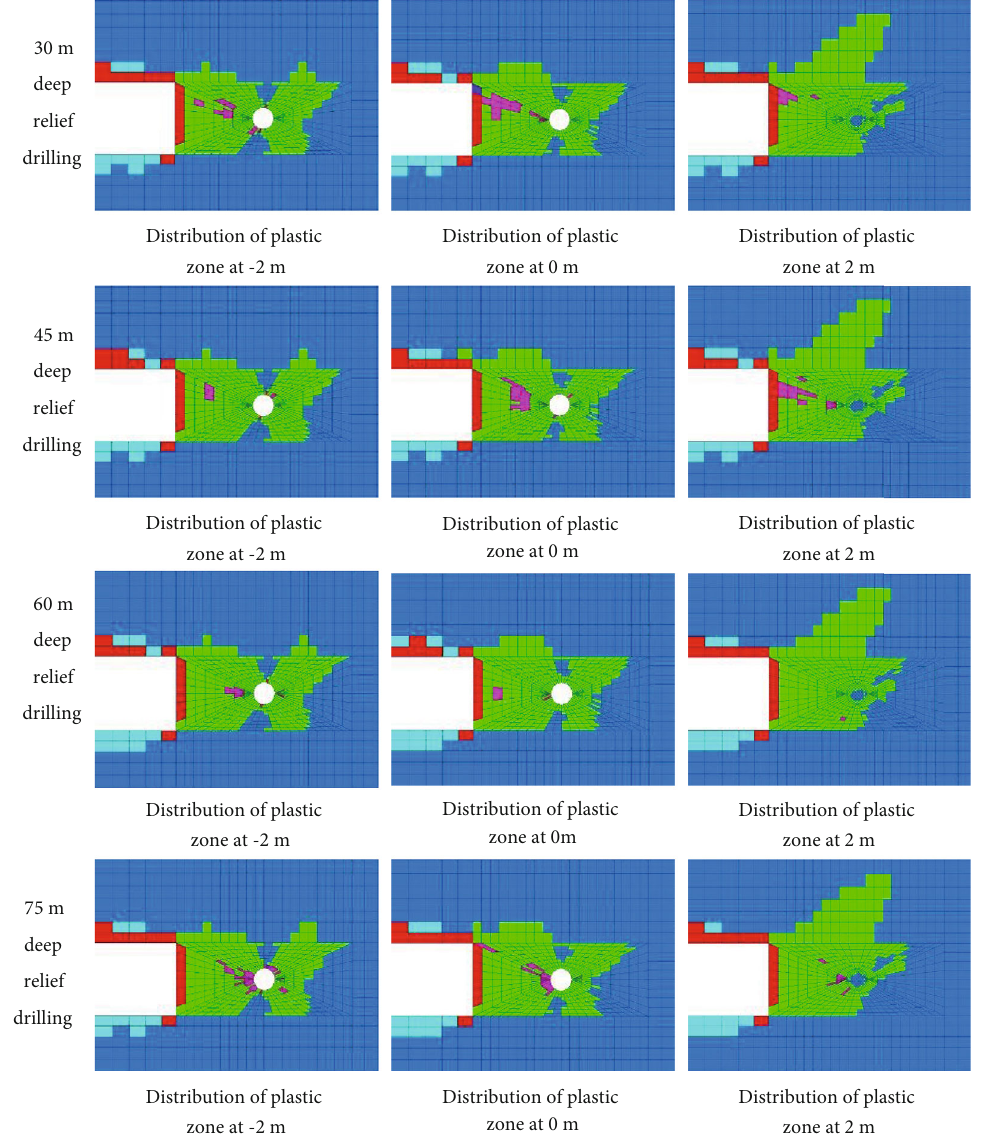
Figure 17: Plastic zone distribution of each section of large-diameter boreholes with di ff erent depths.